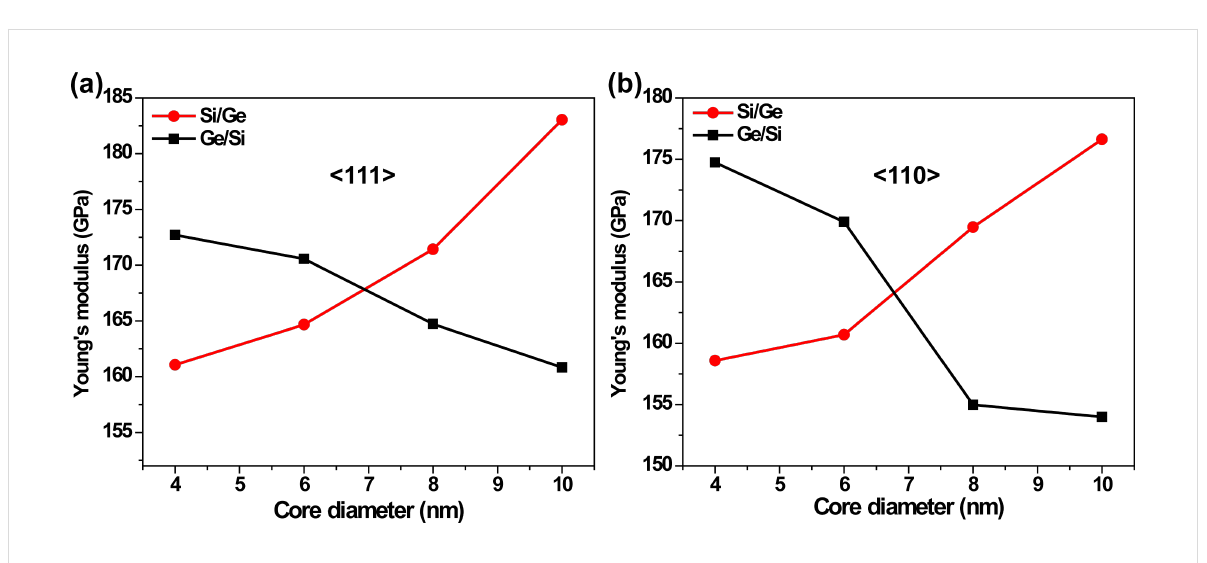
Figure 2: Variation of Young’s modulus with the core diameter of the (a) <111> and (b) <110>-oriented core/shell nanowires. The Si/Ge and Ge/Si structures are found to exhibit opposite trends. The largest core diameter of 10 nm corresponds to the pure, monoelemental